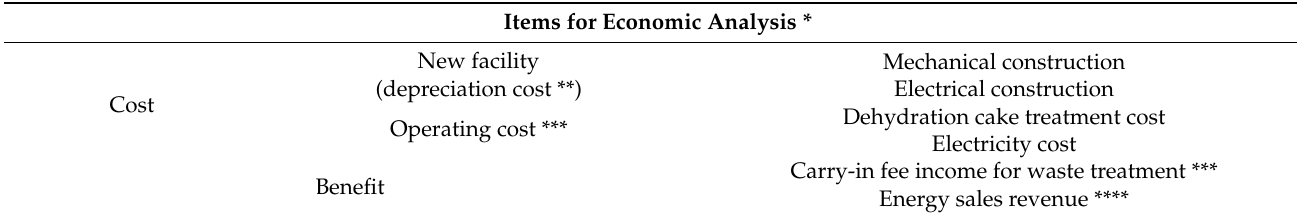
Table 4. Outline of the economic analysis calculation.